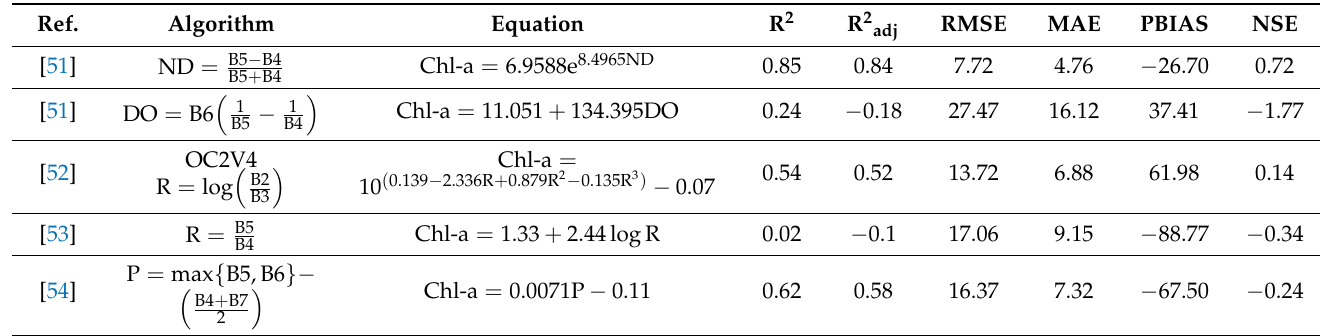
Table 3. Empirical algorithm results without calibration (only testing). BOA images without consid- ering seasonality.